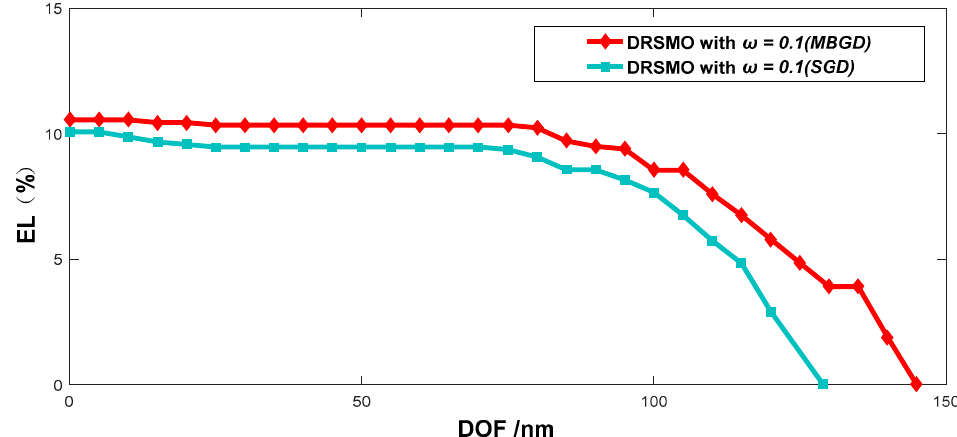
Figure 9. PWs of target 1 for the DRSMO with the same weight factor ω = 0.1 that were proceeded by the SGD algorithm (jasper curve) and MBGD algorithms (red curve), respectively.